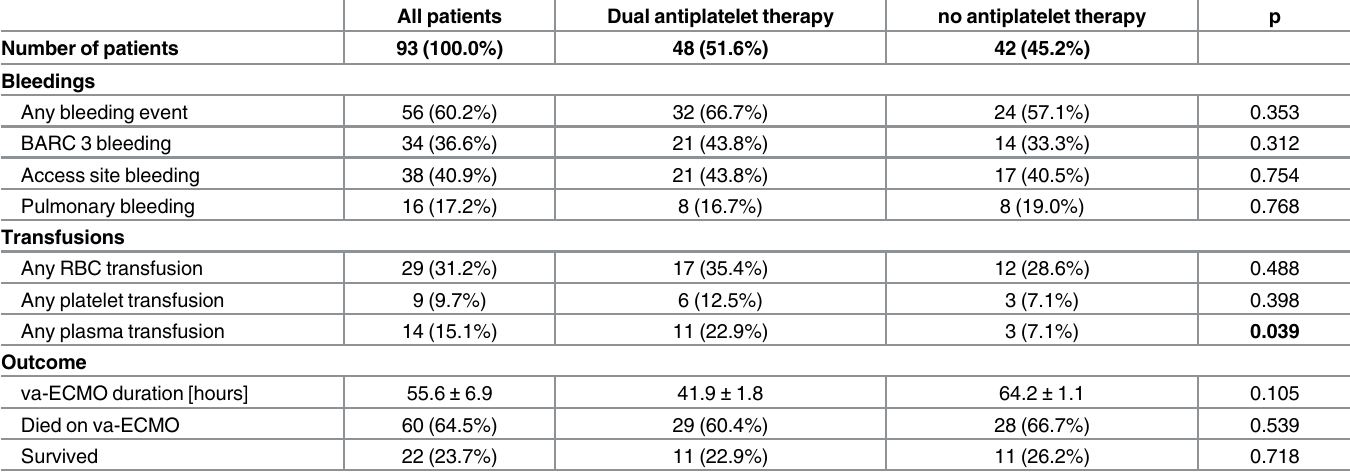
Table 2. Bleeding and transfusions.